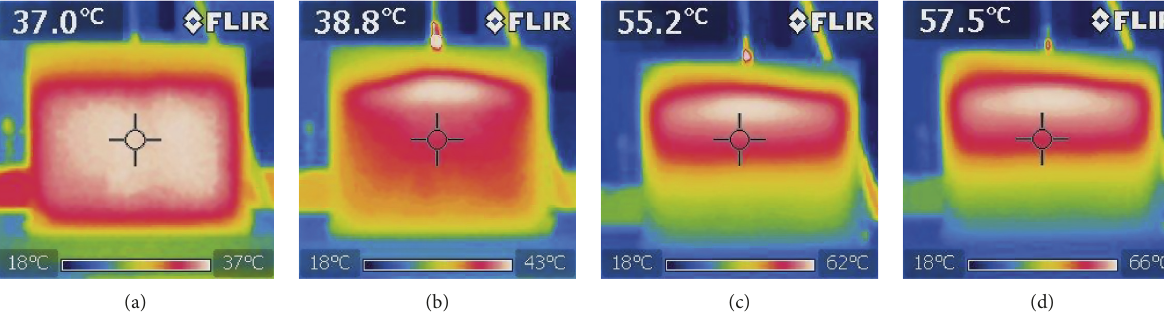
Figure 6: Temperature changes over time on the liver phantom: (a) start, (b) 30sec, (c) 60 sec, and (d) 90sec in the case of antenna with the helical